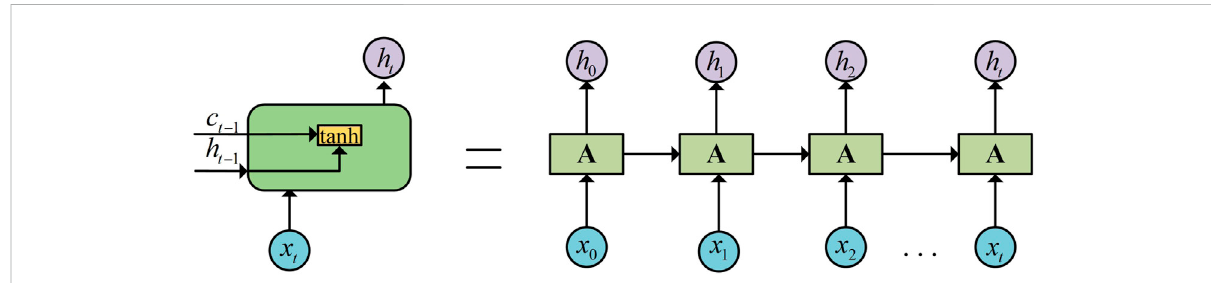
FIGURE 3 Single RNN hidden layer unit expansion structure diagram.